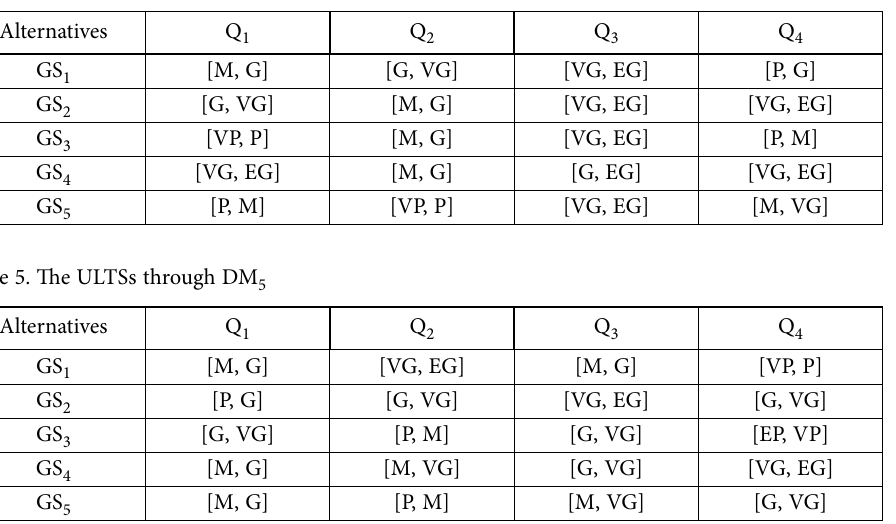
Table 4. The ULTSs through DM 4